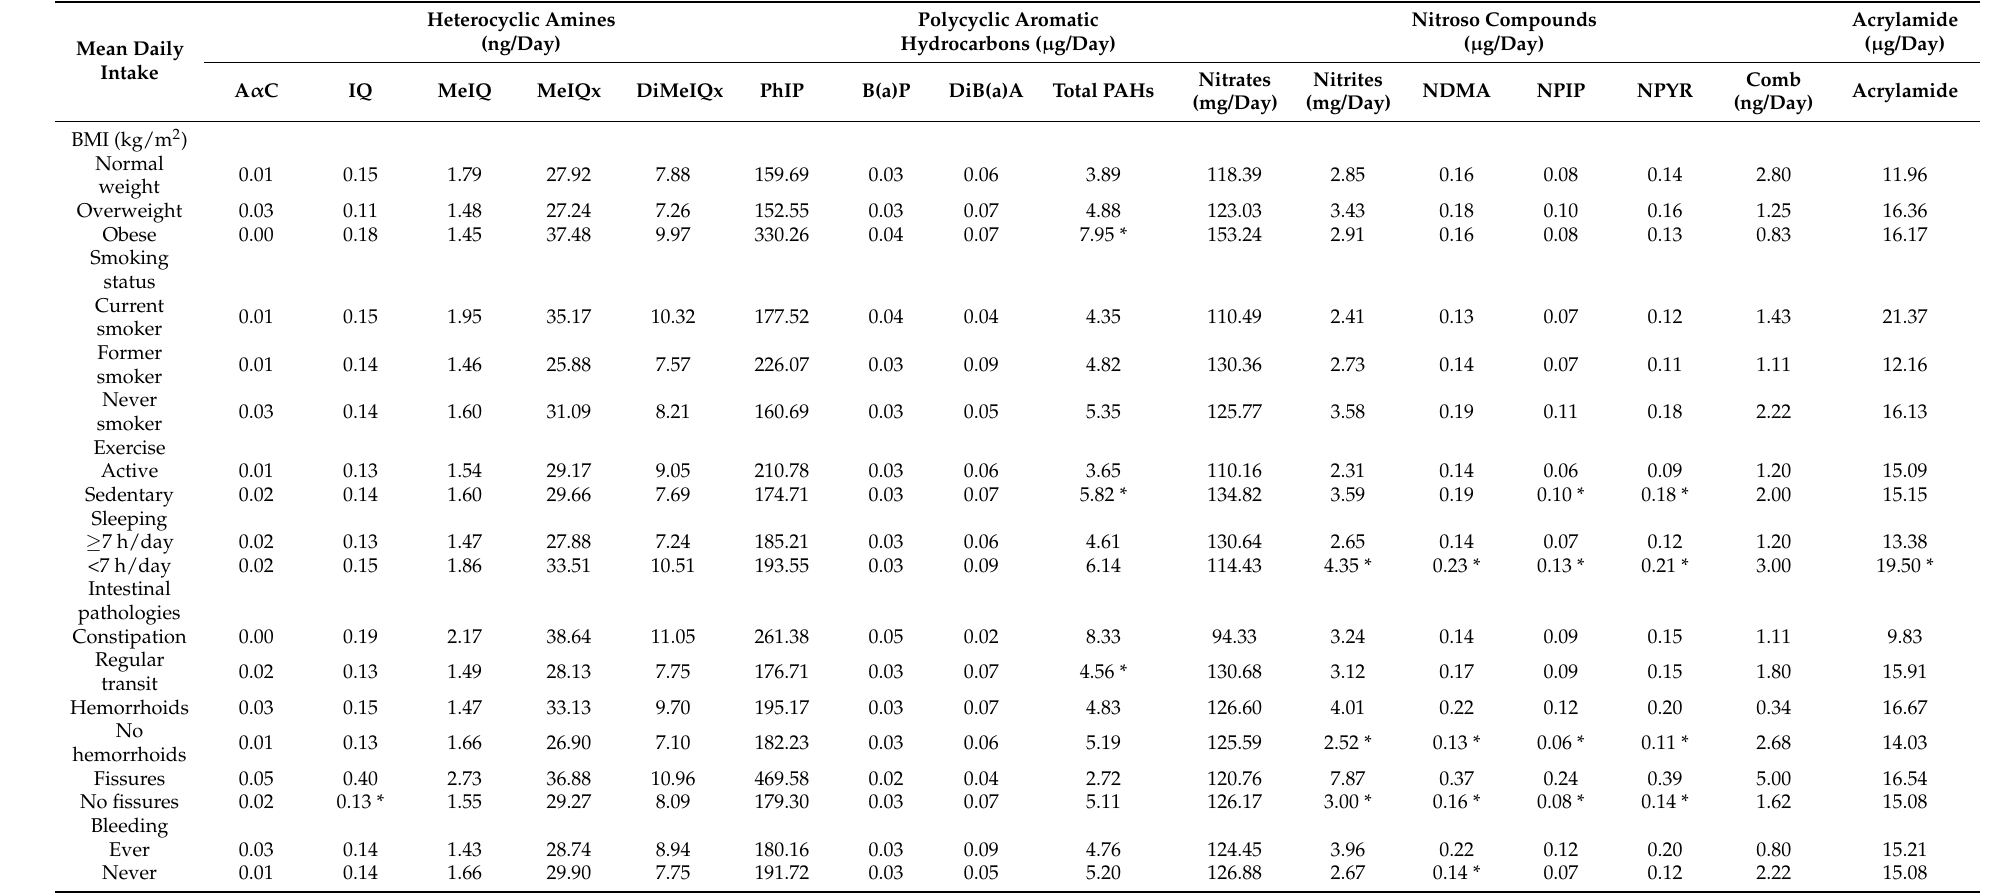
Table 4. Mean xenobiotic intake according to health